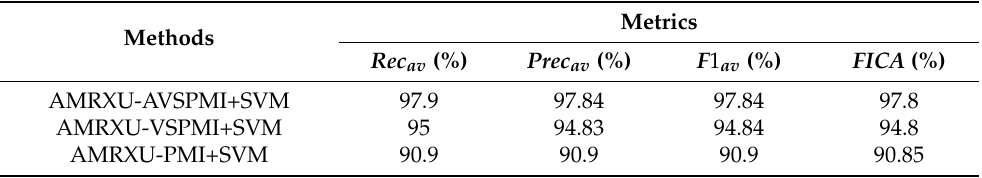
Table 4. The Rec av , Prec av , F 1 av , and FICA averaged over 10 experiments. Table 4. The 𝑅𝑒𝑐